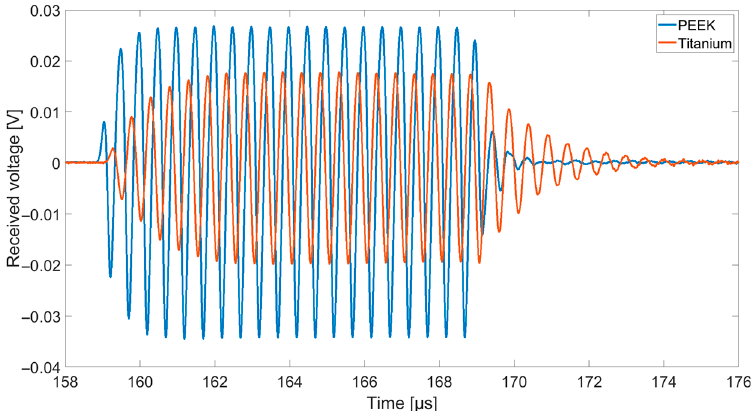
Figure 10. Received voltage signal at 2 MHz for coatings with 170 µm thick silicone and PEEK with a thickness of 25 µm as well as with 170 µm thick silicone with a titanium foil of 32 µm thickness. The resulting frequency spectrum of the receiving voltage is shown in Figure 11. As a reference, the black curve shows the spectrum for the uncoated CMUT Chip 1. Results can be found in Table 2.